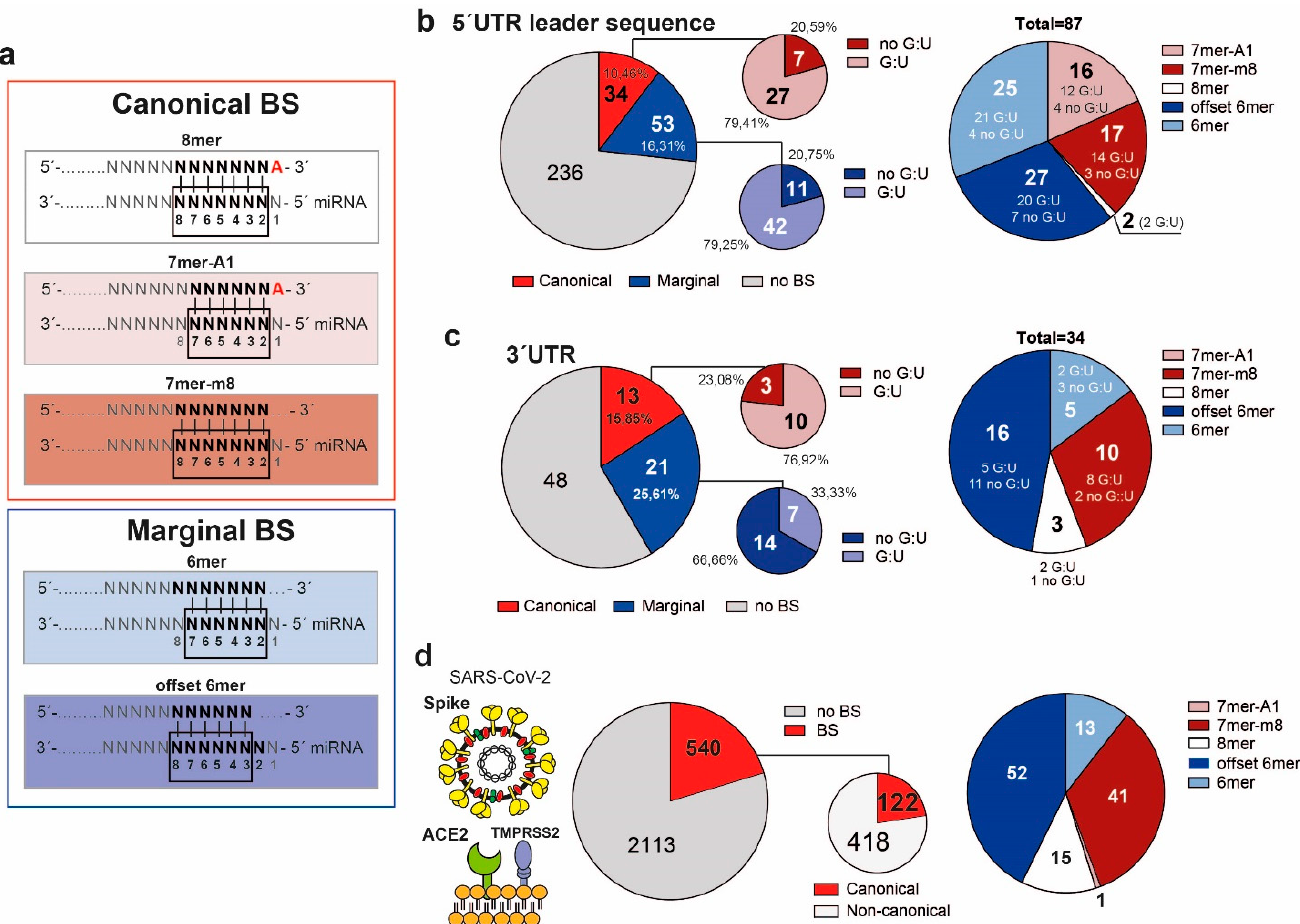
Figure 2. Identified miRNA binding sites (BS) on SARS-CoV-2 leader sequence, genomic 3 ′ UTR, and Spike 3 ′ UTR transcript. ( a ) Bartel classification of miRNA BS according to their seed pairing with mRNA targets, as canonical and marginal. MiRNA seeds involved in the binding with RNA transcript comprise nucleotides (nt) 2–8 (for 8mer, 7mer-m8), nt 2–7 (7mer-A1, 6mer), or nt 3–8 (offset 6mer). ( b – d ) MiRNA BS identified and classified according to Bartel classification, and according to classical (G:C) or noncanonical (G:U) seed pairing in the ( b ) viral leader sequence, ( c ) viral genomic 3 ′ UTR, and ( d ) 3 ′ UTR of glycoprotein Spike transcript. The figure represents the SARS-CoV-2 virus and the target cell receptors TMPRSS2 and ACE2, which interact with Spike protein for endocytosis viral entrance. TMPRSS2: transmembrane protease serine subtype 2; ACE2: angiotensin converting enzyme